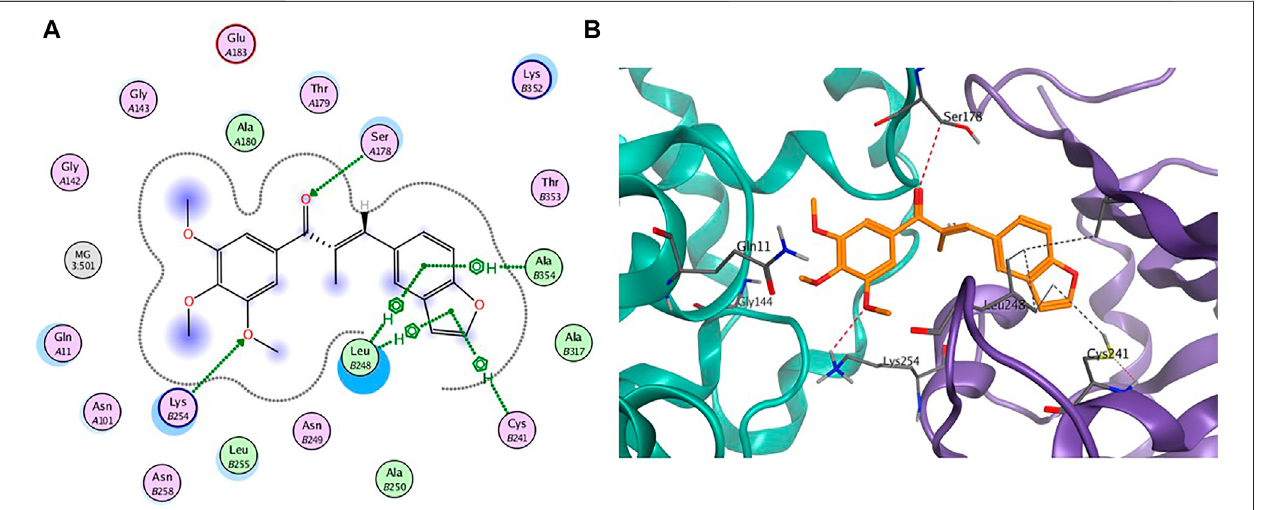
FIGURE 4 | (A) The 2D binding model and hydrogen-bond interactions. (B) A 3D binging model of 7m in different con fi gurations.